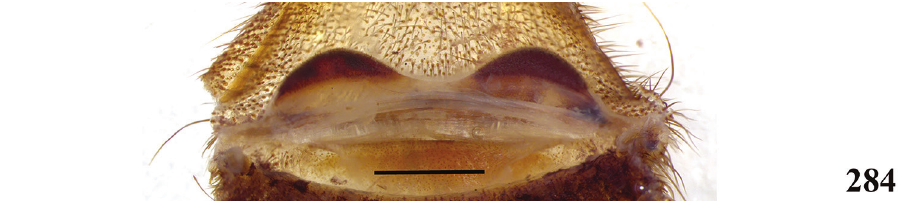
Figure 284. Antillena rickwesti (Bertani & Huff, 2013) comb. n., Dominican Republic (AMNH), sper- mathecae. Scale bars = 1